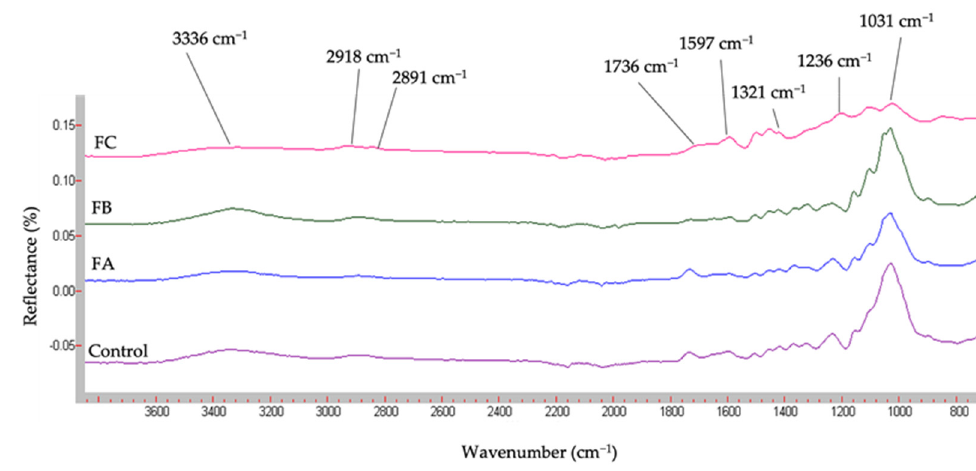
Figure 3. FTIR spectra of samples (Van Soest fractions and control).